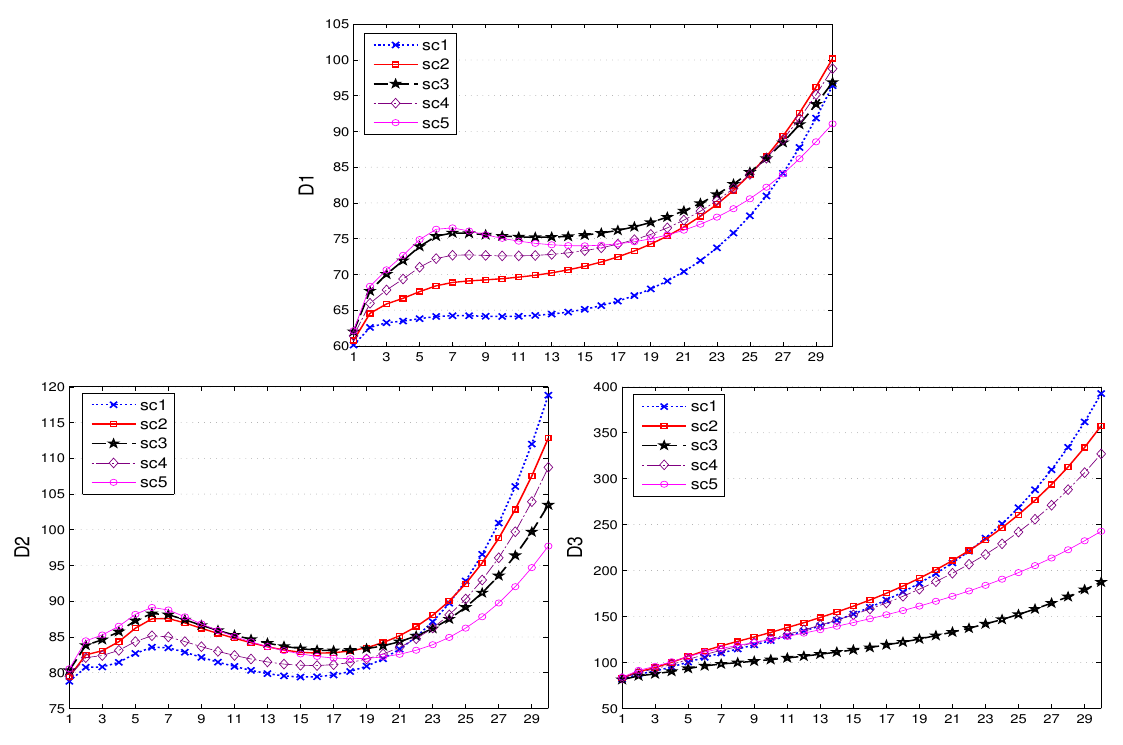
Figure 4. State variable, public debt ( D it ).